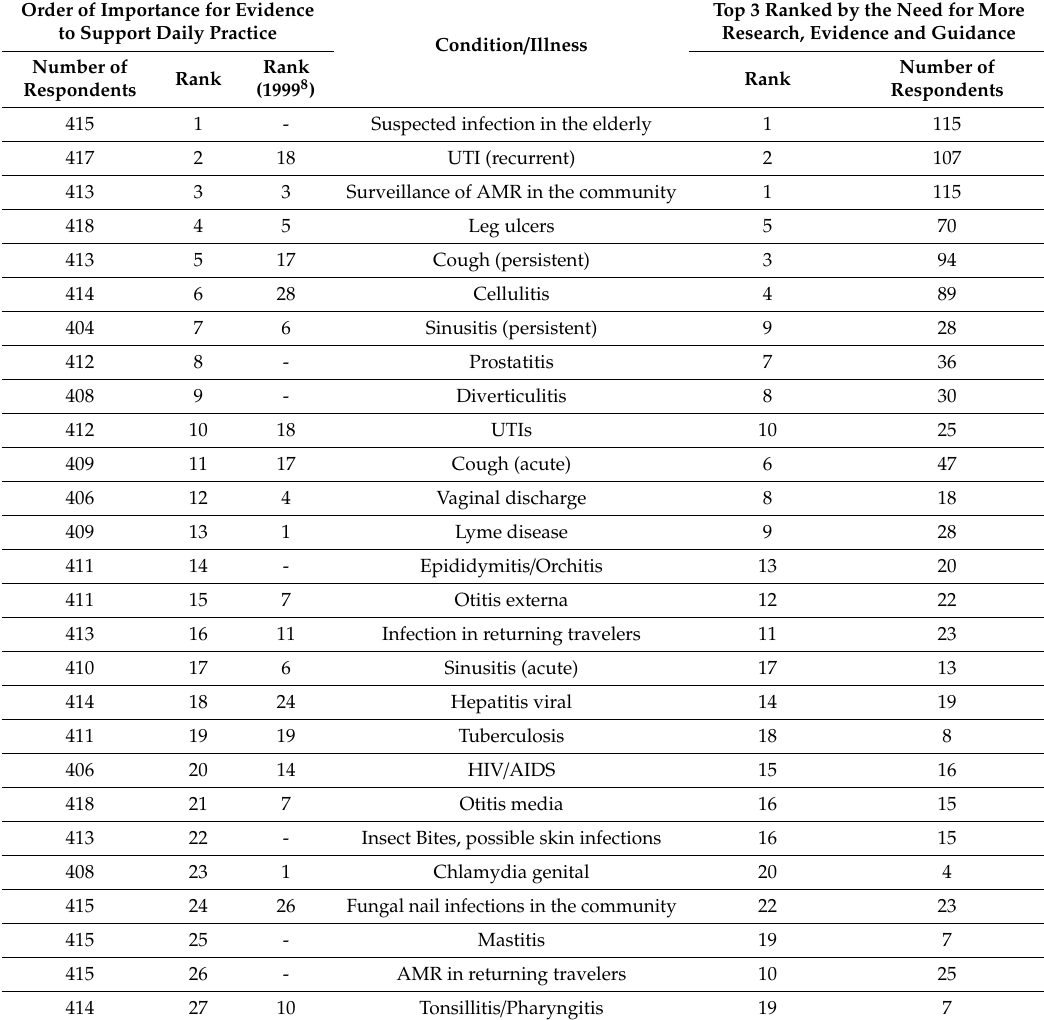
Table 2. All 27 named illnesses / conditions in order of importance for further evidence to support daily